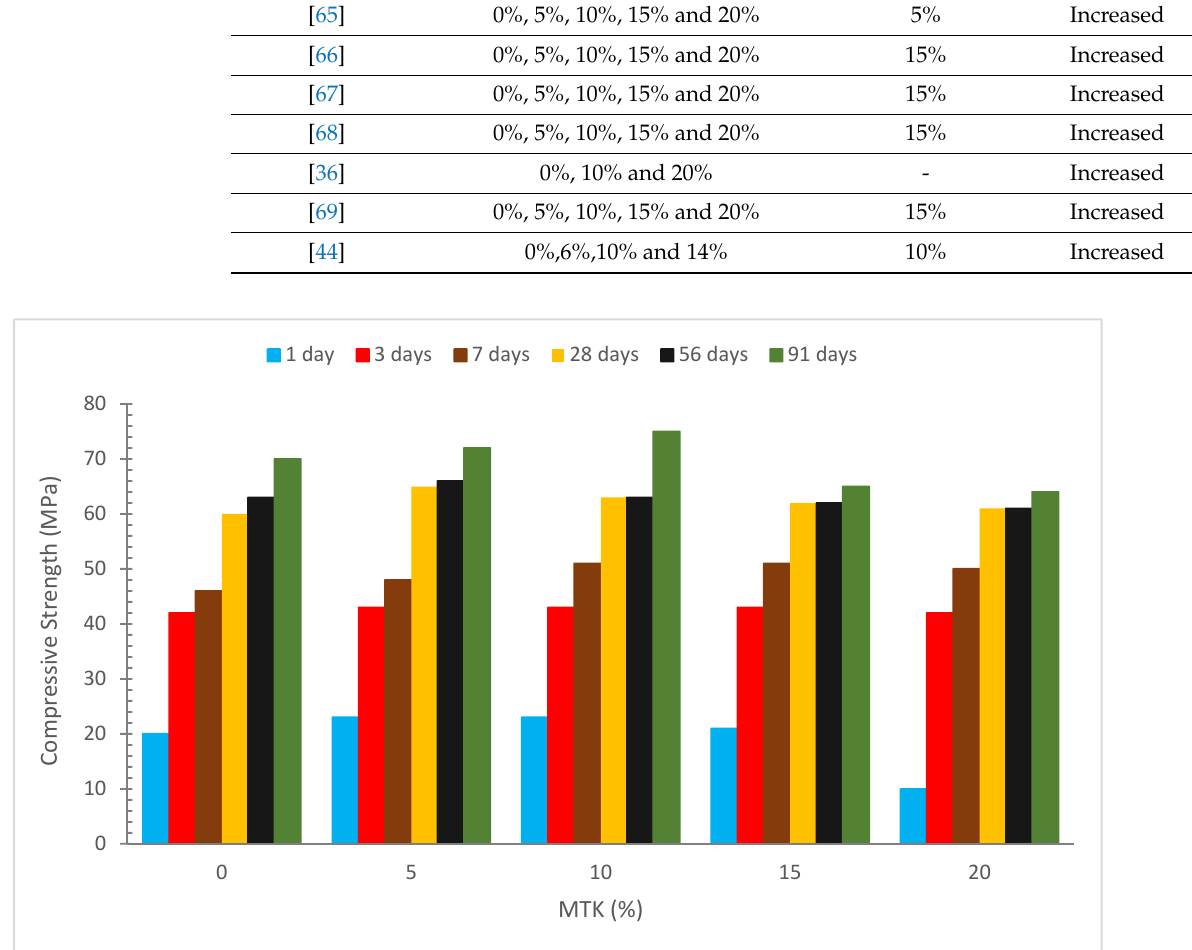
Figure 6. Compressive strength: data source [65]. This is owing to the excess MTK propensity to agglomerate and adsorb around cement particles, causing a delay in the cement’s hydration process and a reduction in the calcium trisilicate (C 3 S) and calcium disilicate (C 2 S) phases in the matrix [70]. Conversely, the increased NMK causes less contact points among cement grains, which function as binding centers [71] and the matrix’s dispersion defect causes a weak interfacial transition zone (ITZ) [72]. The CS of concrete uses increasing concentrations of MTK as a partial cement substitute (5, 10, and 15%). The findings depict that as the MTK substitution ratio